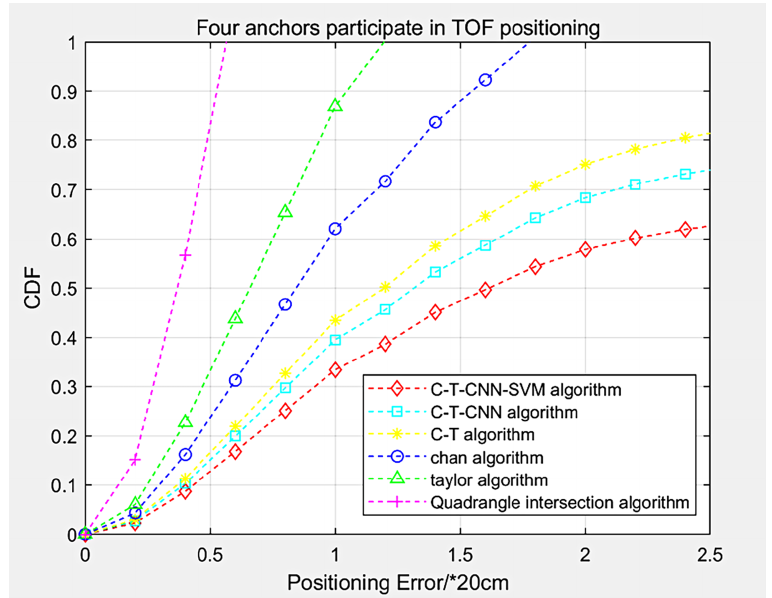
Figure 18. Relation curve between CDF distribution and location error of each algorithm.